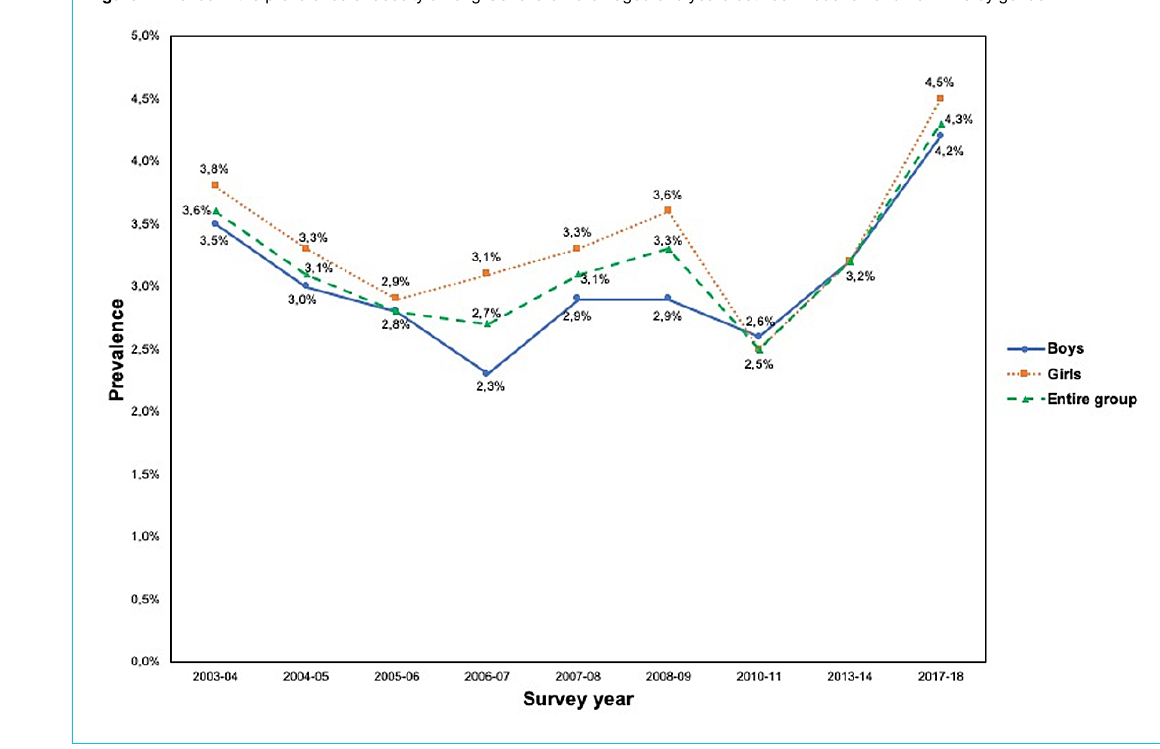
Figure 2: Trends in the prevalence of obesity among Geneva children aged 5–6 years between 2003–04 and 2017–18 by